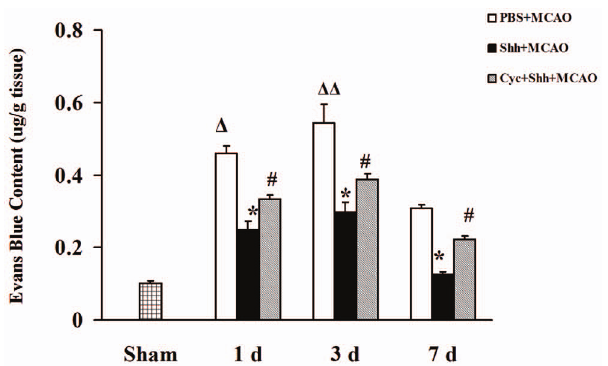
Figure 2. Shh Treatment Preserves BBB permeability. After establishment of pMCAO, rats were intracerebroventricularly injected 3 m L of PBS, 3 m g of Shh, and Shh (3 m g) plus cyclopamine (Cyc, 30 m g). The BBB permeability was detected by Evans Blue extravasation at indicated time points (1 d, 3 d, and 7 d). Bar graph shows that Shh decreased the BBB leakage in pMCAO and the effect was reversed by the specific Shh antagonist Cyc. Grouping was the same as above. D P , 0.01 vs. the Sham group, * P , 0.01 vs. the PBS group at the same time point, # P , 0.01 vs. the Shh group at the same time point, DD P , 0.01 vs. the PBS (1 d) group. Each experiment was repeated three times (n=6, each group).